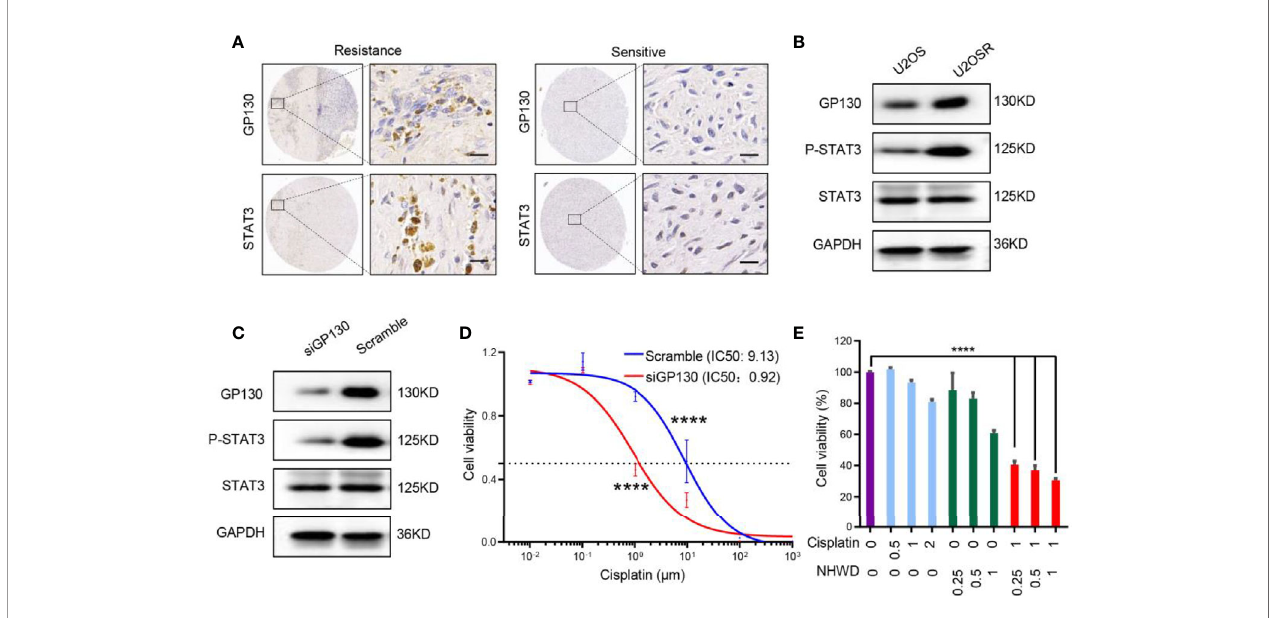
FIGURE 4 | NHWD-870 sensitizes osteosarcoma cells to chemosensitivity by repressing GP130. (A) The expression level of GP130 in chemosensitive and chemoresistance patients was detected using immunohistochemistry. Scale bar = 50 m m. (B) The expression level of GP130 in chemosensitive (U2OS) and chemoresistance (U2OSR) osteosarcoma cell lines was detected using western blotting. (C) 143B cells were transfected with GP130 siRNA for 72 hours. GP130, p-STAT3 Y705, STAT3 and GAPDH were assessed by western blot. (D) Dose-response curve of the 143B scramble and 143B GP130 siRNA cell lines. Data are mean ± SEM. (****P < 0.0001). (E) Cells were treated with NHWD-870 and cisplatin individually or in combination at the indicated concentrations for 72 hours, and cell viability was assessed with a CCK8 assay. Data are shown as mean ± SD. (****P <